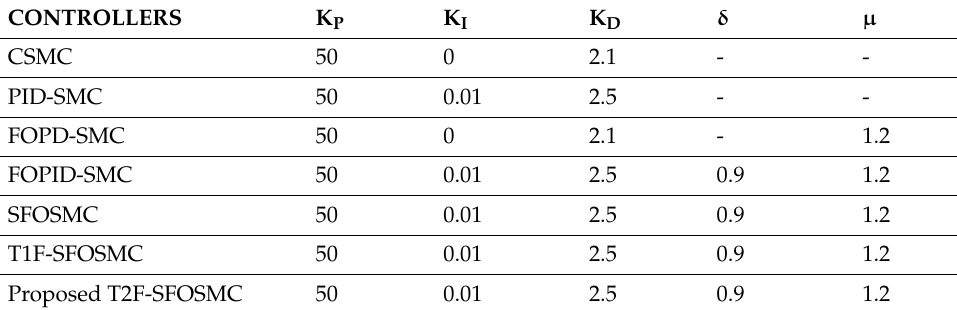
Table 3. Gain parameters for different